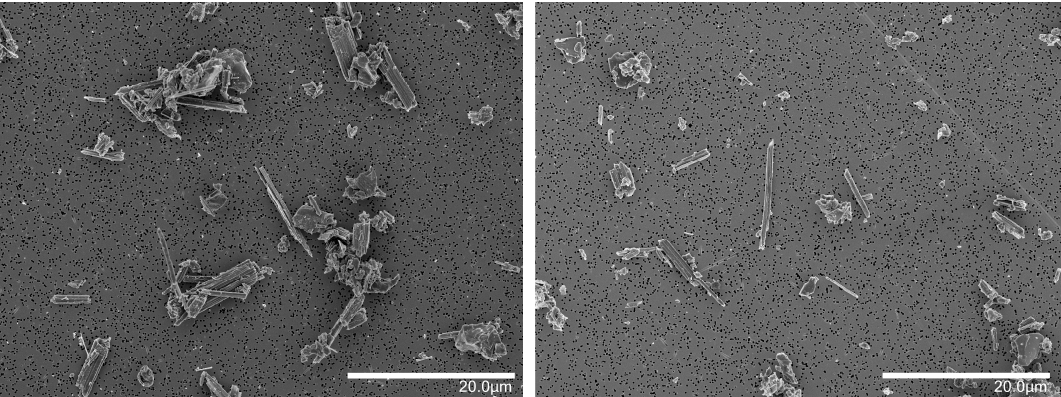
Figure 8. SEM images of nearfield aerosol samples of WP13 ( left ) and WP14 ( right ) with WHO- Figure8. SEMimagesofnearfieldaerosolsamplesofWP13( left )andWP14( right )withWHO-fragments fragments of the processed carbon fiber. The length of the scale bar is 20 μm . of the processed carbon fiber. The length of the scale bar is